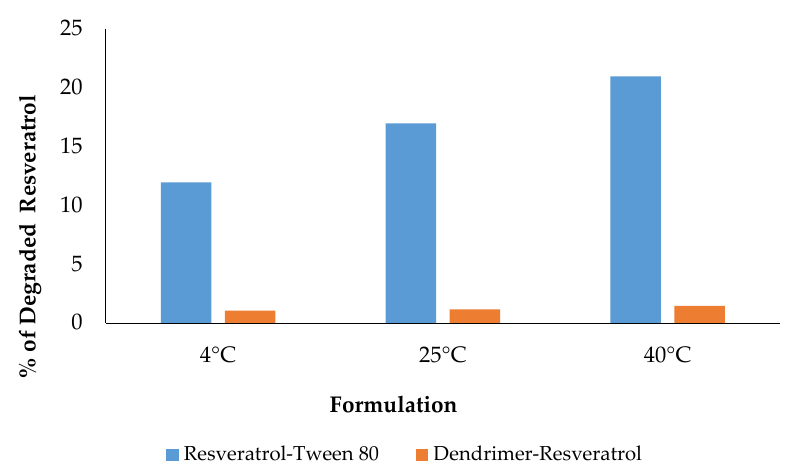
Figure 9. Percentage of degraded resveratrol remained in the formulations after Day 1.